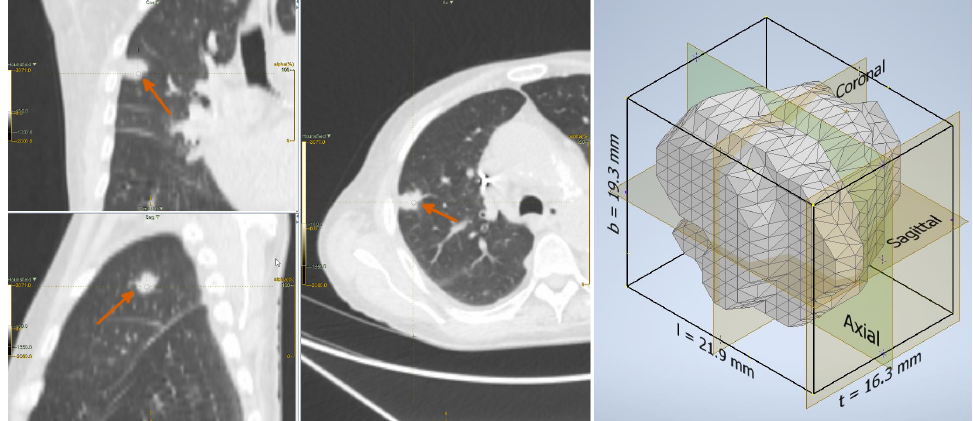
Figure 2. Adenocarcinoma in a 76-year-old man: lesion on the CT scan ( left ) and the reconstructed three-dimensional volume within the axis-aligned bounding box ( right ).